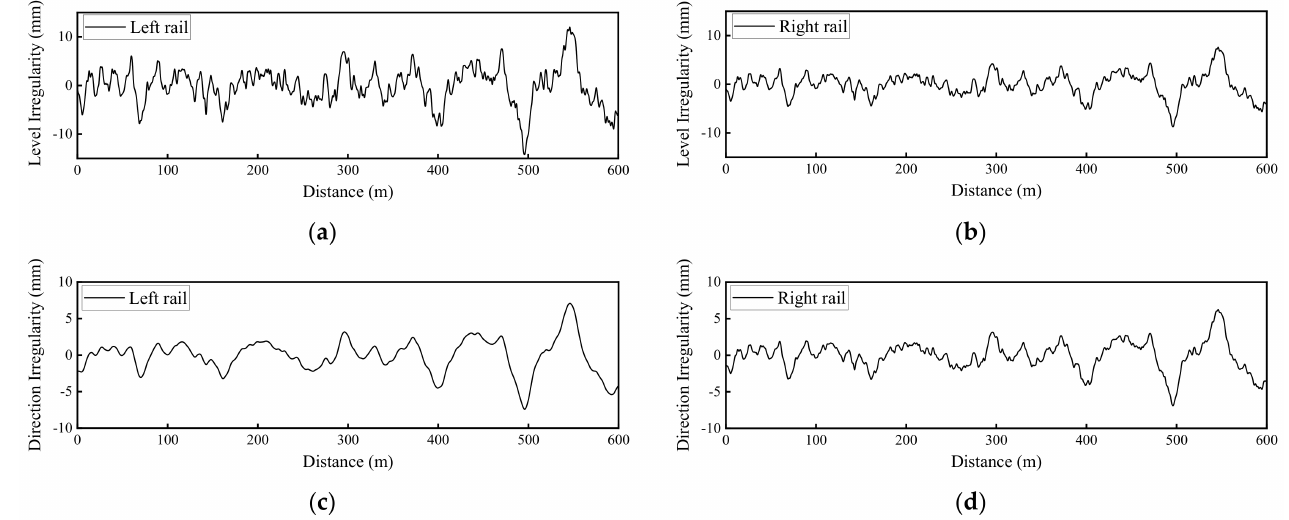
Figure 5. Illustration of the spectrum sample of track irregularity used: ( a ) Level irregularity of left rail; ( b ) level irregularity of right rail; ( c ) direction irregularity of left rail; and ( d ) direction irregularity of right